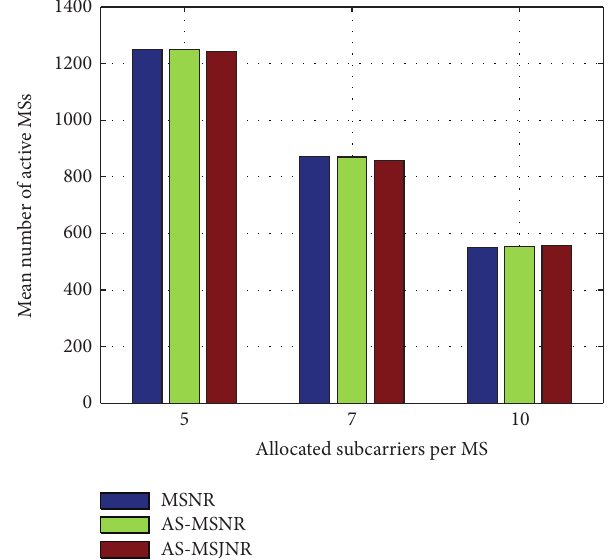
Figure 5: Mean number of active MSs for QPSK modulation and two tiers of cells around the central cell.